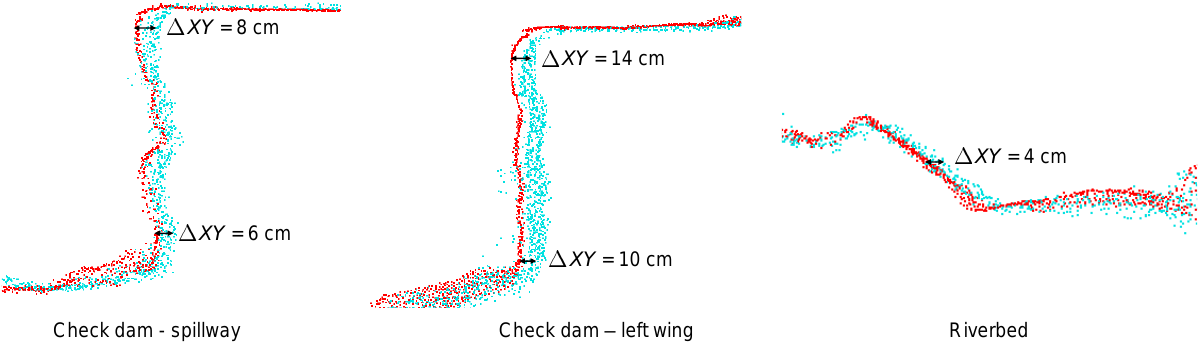
Figure 9. Vertical sections of the Vegliato reach extracted at the spillway of the upstream check dam, at the left wing and in the middle of the riverbed. The HERON Lite point cloud is shown in cyan, while the photogrammetric one in red.